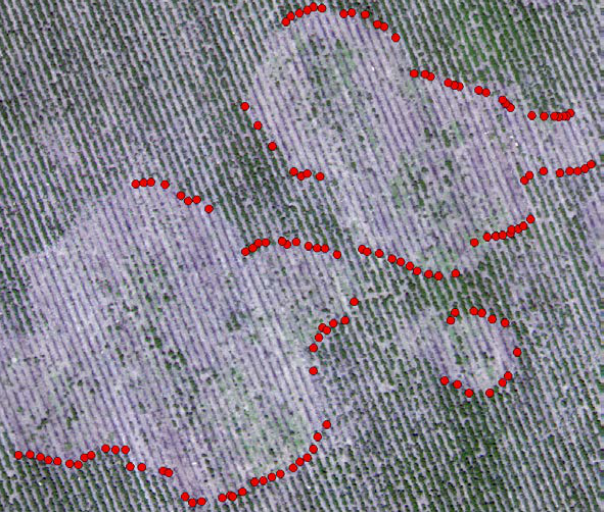
Figure 2. The images were captured from ( a ) a fixed-wing unmanned aerial vehicle (UAV) “TuffWing UAV Mapper” with ( b ) MicaSense RedEdge camera.